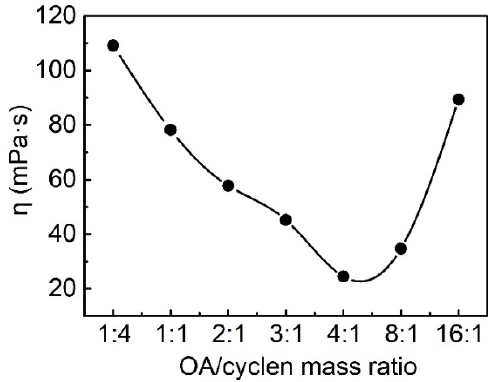
Figure 6. The influence of the molar ratio of OA and cyclen on heavy oil emulsion viscosity at 50 °C. The total concentration of OA and cyclen was 3.0 wt%, and the mass ratio of oil and surfactant OA/cyclen aqueous solution was set as 7:3.